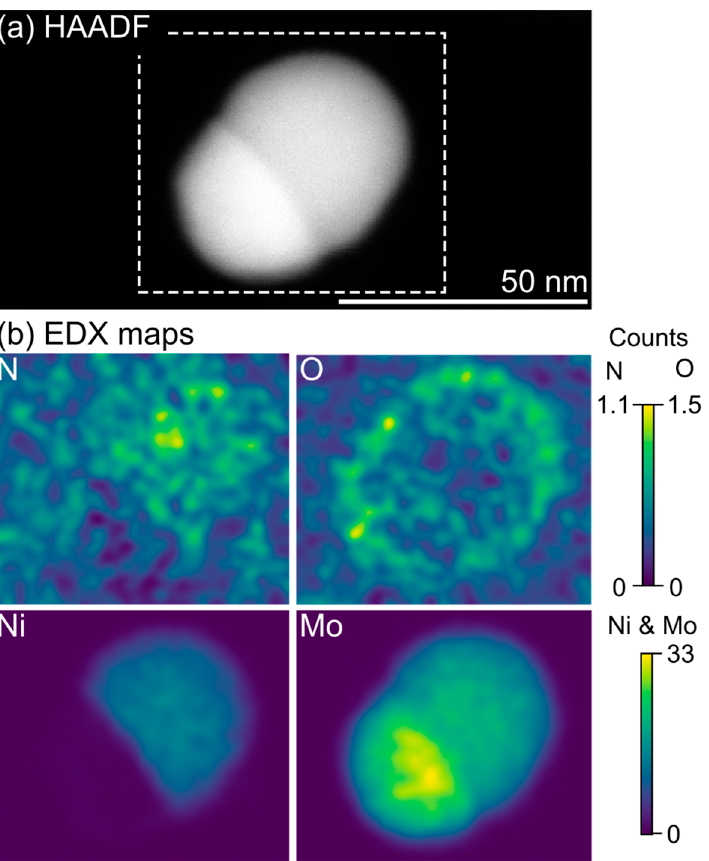
Figure 2. ( a ) STEM-HAADF overview image of a biphasic particle exhibiting a Janus morphology. ( b ) EDX mapping of the particle shows one phase containing elemental Mo (lower half) and the other containing an Ni-Mo compound with an increased N signal (upper half). Due to sample transfer being conducted in ambient air, the particles have a thin, oxidized shell.